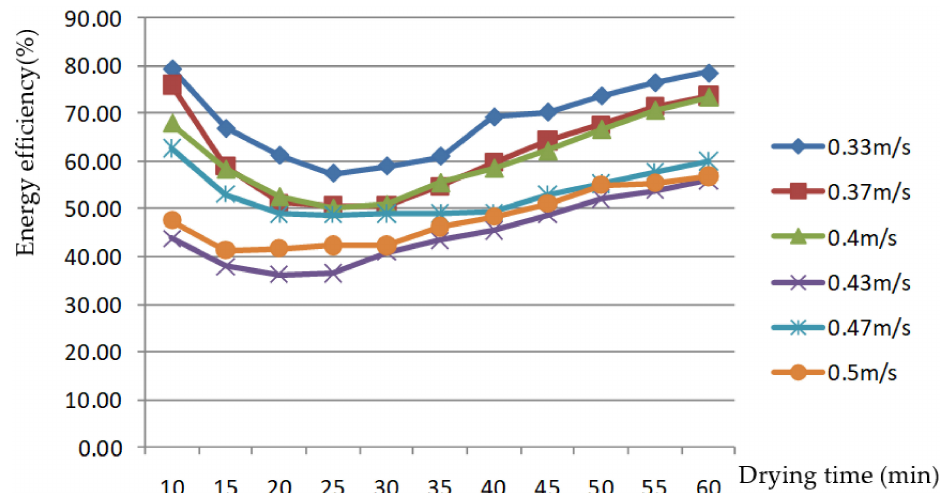
Figure 7. Energy efficiency changes with drying time at different air velocities.